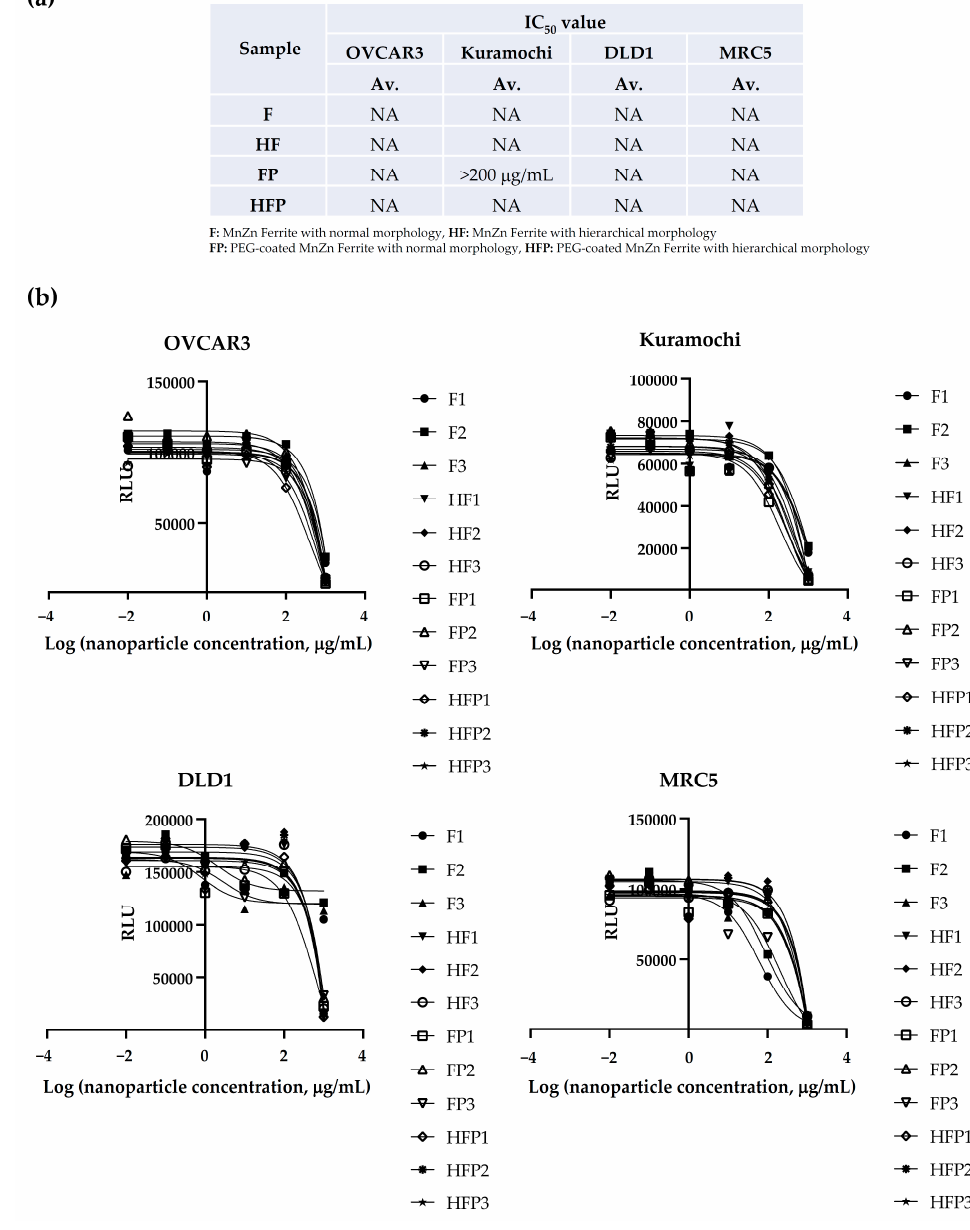
Figure A1. ( a ) Summary of the data presented in b. Values are expressed as µg/mL. Av: average, ( b ) Nonlinear regression analysis of different cells treated with nanoparticles in triplicates. On the Y axis, the relative luminescent values (RLU) are reported. On the X axis, the concentration of nanoparticles on a logarithmic scale is reported.